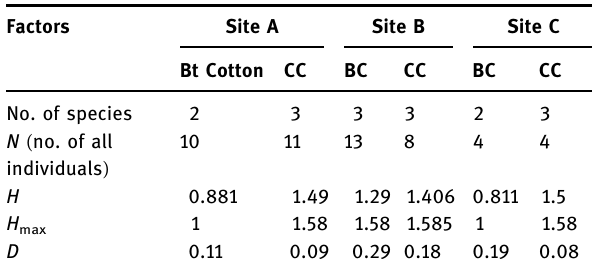
Table 1: Shannon diversity index of fl ying insects in the BC and CC